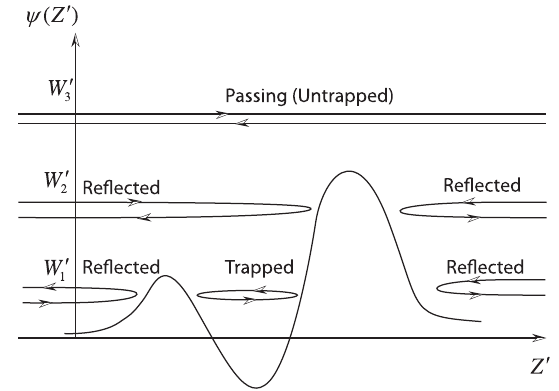
.FIG. 11. Illustrative plot of the effective potential ψ ð Z 0 Þ versus Z 0 occurring in Eq. (33) showing the three classes of particle orbits corresponding to: passing (untrapped) particles with energy W 0 3 ; reflected particles with energy W 0 2 ; and reflected or trapped particles (depending on the range of Z 0 ) with energy W 0 1 . The form of ψ ð Z 0 Þ in Fig. 11 corresponds to an isolated pulse with ψ ð Z 0 → (cid:2) ∞ Þ ¼ 0